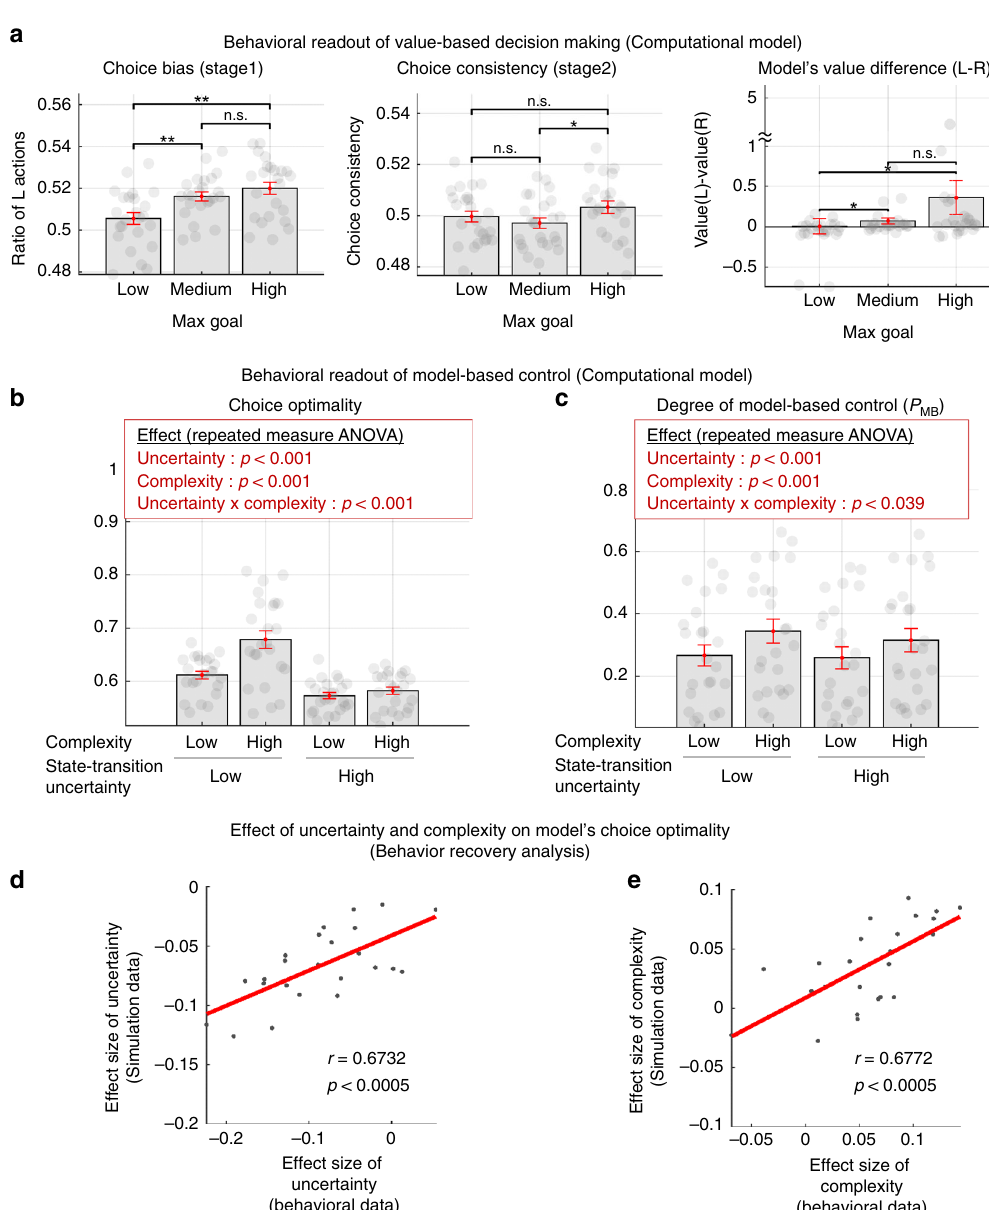
Fig. 6 Computational model fi tting results. a Choice bias (left), choice consistency (middle), and the average value difference (right) of our computational model of arbitration control (Fig. 5b). For this, we ran a deterministic simulation in which the best- fi tting version of the arbitration model, using parameters obtained from fi tting to participants behavior, experiences exactly the same episode of events as each individual subject, and we generated the trial-by-trial outputs. The max goal conditions are de fi ned in the same way as in the Fig. 2a. Error bars are SEM across subjects. Note that both the choice bias and choice consistency patterns of the model (the left and the middle plot) are fully consistent with the behavioral results (Fig. 2b). Second, the values difference (left – right choice) of the model is also consistent with this fi nding (the right plot), suggesting that these behavioral patterns are originated from value learning. In summary, our computational model encapsulates the essence of subjects ’ choice behavior guided by reward-based learning. b Patterns of choice optimality generated by the best- fi tting model, using parameters obtained from fi tting to participants behavior. For this, the model was run on the task (1000 times), and we computed choice optimality measures in the same way as in Fig. 3. c Degree of engagement of model-based control predicted by the computational model, based on the model fi ts to individual participants. P MB corresponds to the weights allocated to the MB strategy. Shown in the red box are the effect of the two experimental variables on each measure (two-way repeated measures ANOVA; also see Supplementary Table 4 for full details). Error bars are SEM across subjects. d , e Behavioral effect recovery analysis. The individual effect sizes of uncertainty ( d ) and complexity ( e ) on choice optimality of subjects (true data) were compared with those of our computational model (simulated fi ndings, we found SPE signals in dorsolateral prefrontal cortex computational model that best- fi t behavior is regressed against the fMRI data (see Methods). First, we replicated previous fi nd- (dlPFC) ( p < 0.05 family-wise error (FWE) corrected) 24,30 and RPE signals in the ventral striatum ( p < 0.05 small volume cor- ings indicating neural encoding of prediction error signals, SPE rected) 30,34,35 . Second, we replicated chosen value signal corre- and RPE, two key variables necessary for updating MB and MF lates for the MB and MF controllers. The MB value signal was RL values (see Supplementary Table 2). Consistent with previous